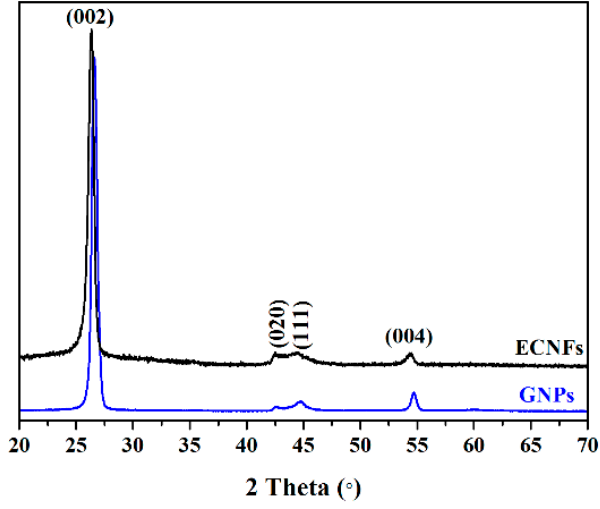
Figure 5. ECNF and GNP stacked XRD spectra.